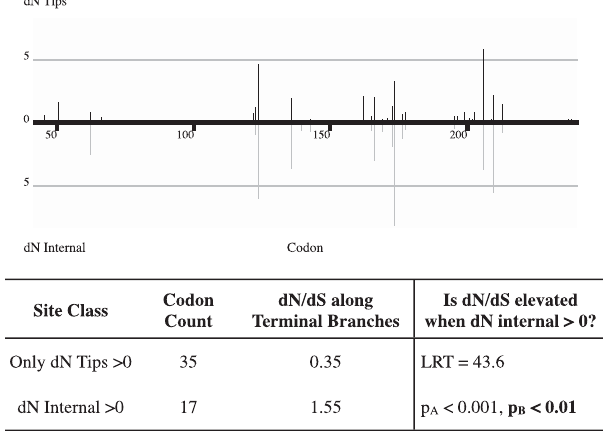
Figure 1. Patterns of Population and Individual Level Nonsynonymous Evolution in the Two Protease Samples MLEs of nonsynonymous substitution rates along internal (dN Internal) and terminal (dN Tips) branches were derived using the IFEL method. dN/ dS estimates and p -values in the tables were obtained with the Population Level Adaptation test. p A and p B and denote, respectively, the asymptotic and parametric bootstrap significance levels for the likelihood ratio test. DOI: 10.1371/journal.pcbi.0020062.g001